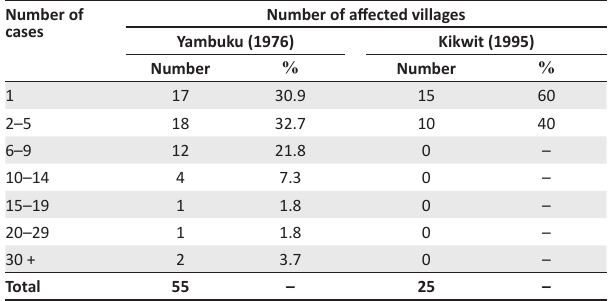
Number of affected villages